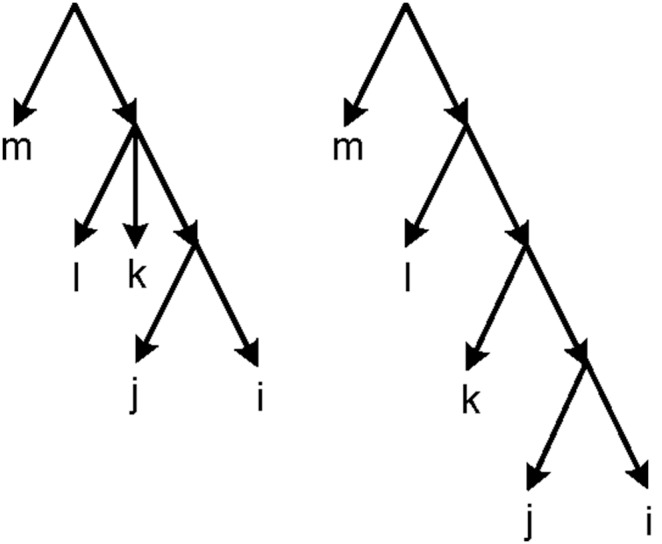
An example of binarization.The binary tree is a binarization of the non-binary tree.